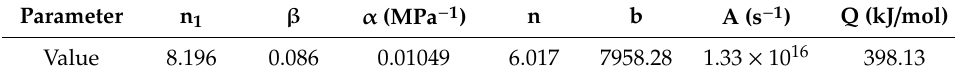
Figure 6. The linear relationship between ln[sinh( ασ )] and ln Z . Table 3. The parameters in the constitutive equations of testing steel at peak stress.